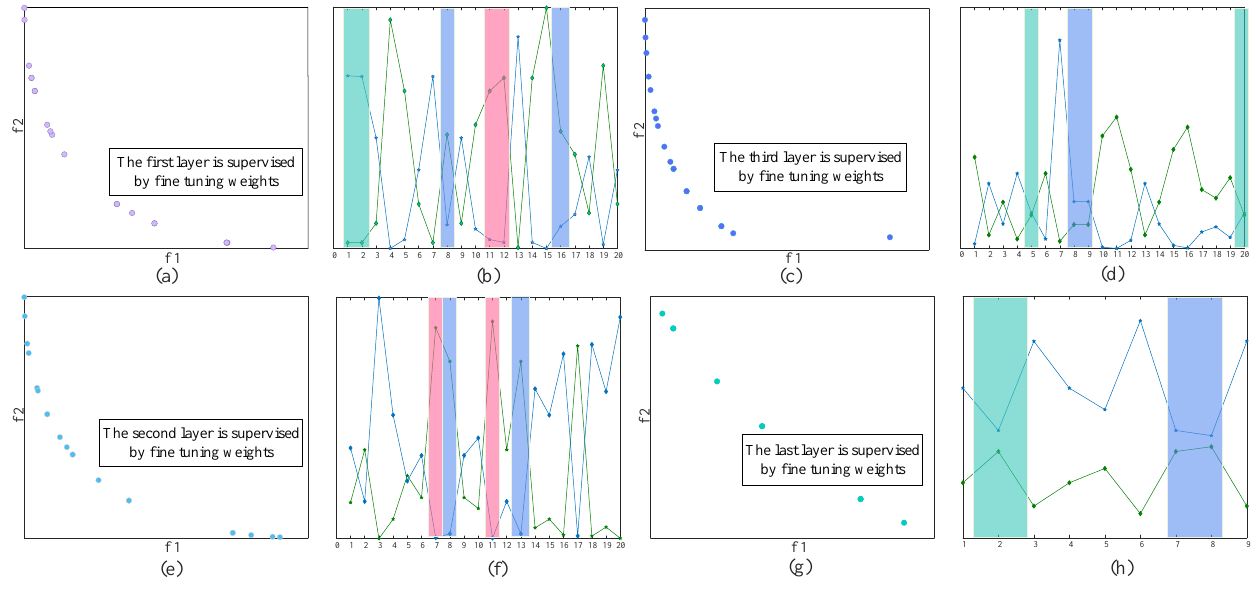
Figure 5. Principal component distribution of feature extraction.